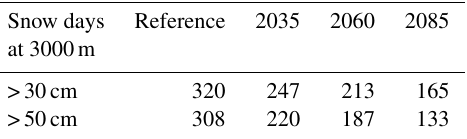
Table 2. Number of days with over 30/50cm snow depth at 3000ma.s.l. in the Aare region for the reference period and the three future scenario periods based on the A2 emission